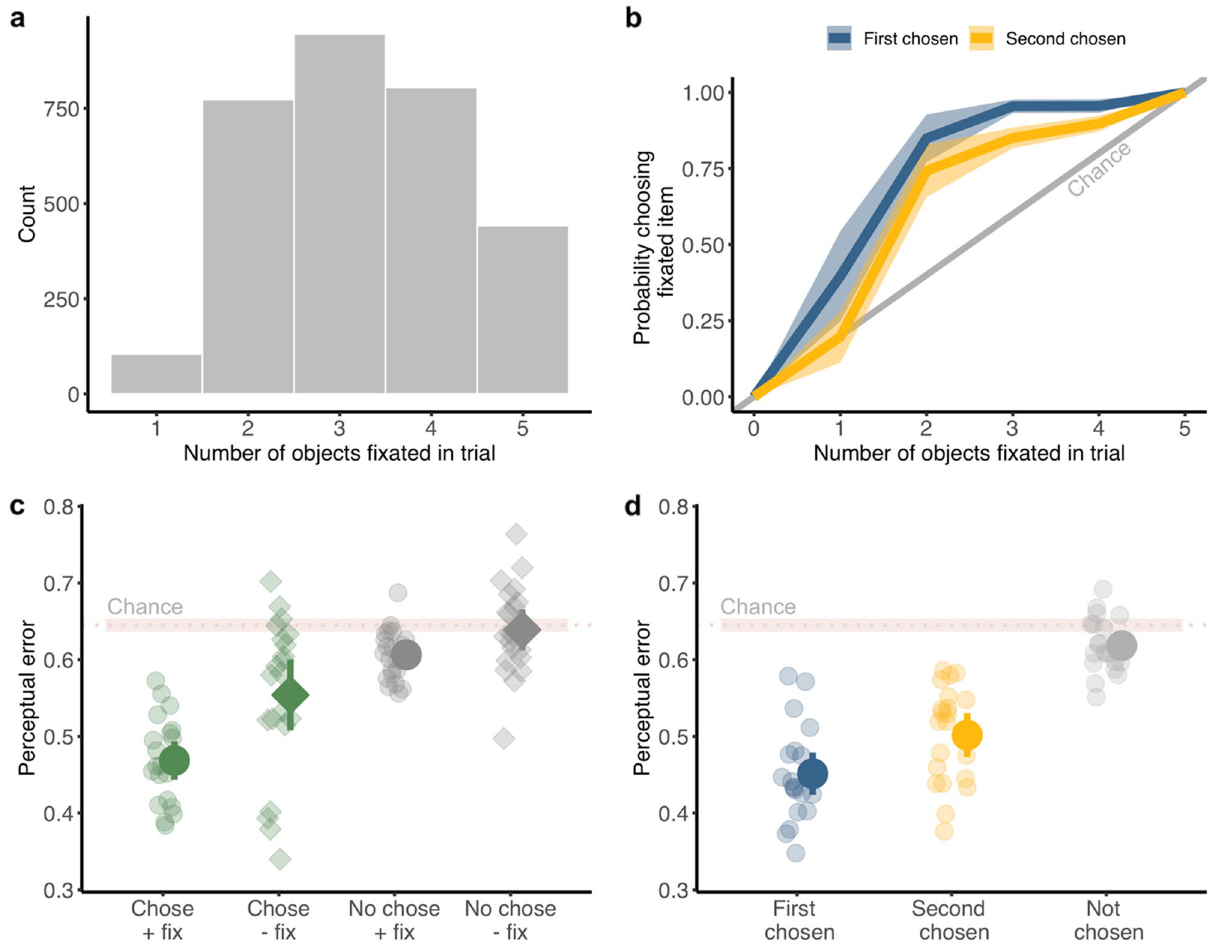
Figure 3. Fixations vs report choice vs performance. ( a ) Histogram of number of objects fixated in a trial, across all trials and participants. ( b ) Participants were more likely to choose objects that had been fixated, irrespective of how many items were fixated in a trial, for both first chosen (blue) and second chosen (yellow) objects. The grey diagonal line denotes chance performance for choosing a fixated item. ( c ) Perceptual error for report choice (chosen = green, not-chosen = grey) and fixation (fixated = circles, not-fixated = diamonds). ( d ) Perceptual error for first (blue), second (yellow) and not-chosen (grey) objects. ( c , d ) Light colors indicate individual participants and dark colors the mean across participants. The pink horizontal line denotes chance (for each trial, perceptual error was calculated using the perceptual similarity curve of one random object out of all 577 objects, and chance is the mean performance for this randomly-shuffled error). ( b – d ) All error bars are 95% confidence